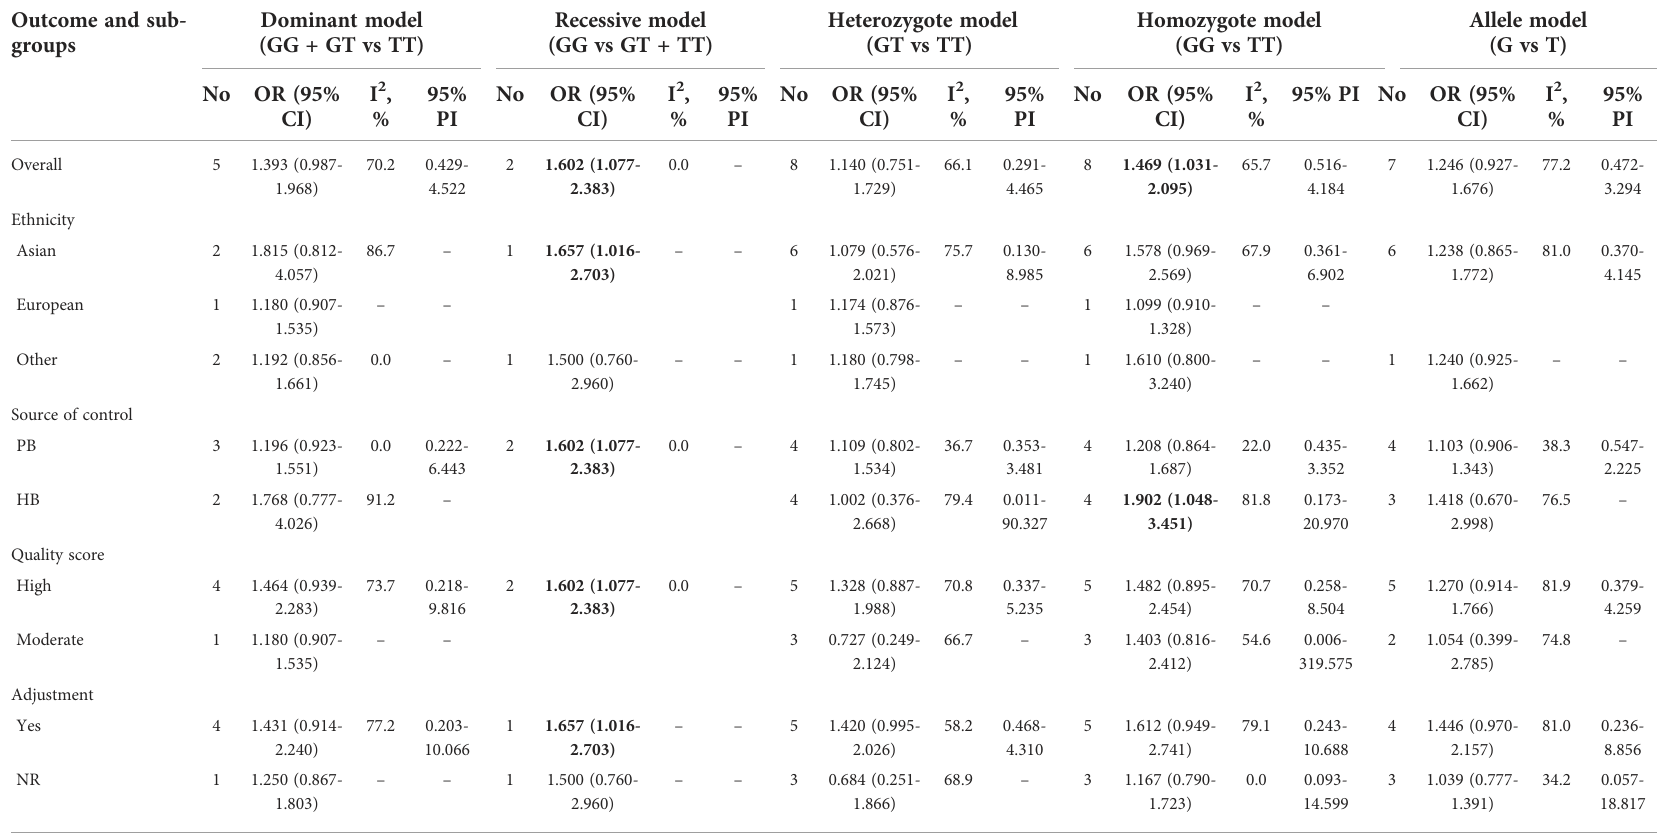
TABLE 3 The association between MDM2 rs2279744 polymorphism and cervical cancer